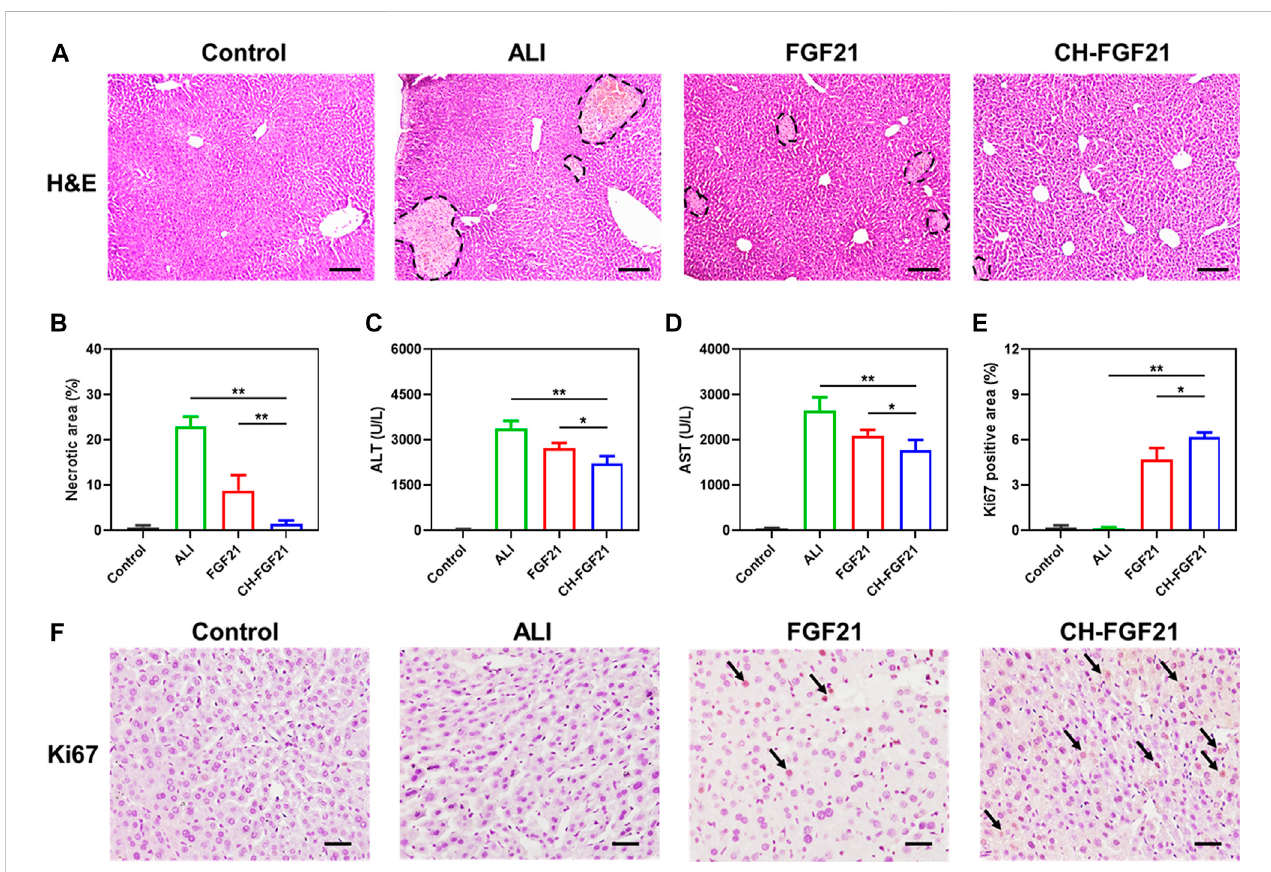
FIGURE 5 ProtectiveeffectsofCH-FGF21onALImice. (A) Hematoxylinandeosin(H&E)stainingoflivertissues. Scalebar=100 μ m. (B) Necroticareainlivertissue. Levels of (C) alanine aminotransferase (ALT) and (D) aspartate aminotransferase (AST) in the blood of mice in each group 24 h after treatment. (E) Quanti fi cation of the positive area of Ki67 according to immunohistochemistry. (F) Immunohistochemical staining of Ki67 in liver tissue. Scale bar = 50 μ m. Data are the mean ± SD ( n = 8). * p ≤ .05, ** p ≤